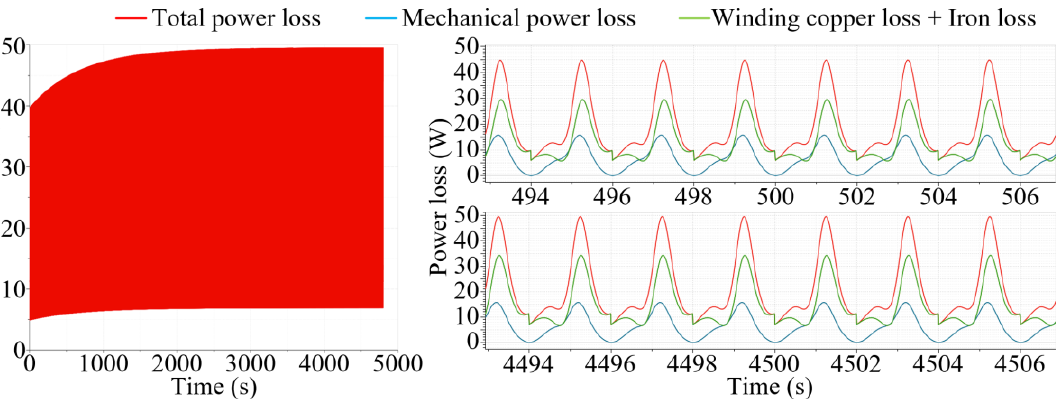
Figure 11. Variation of power loss over time.